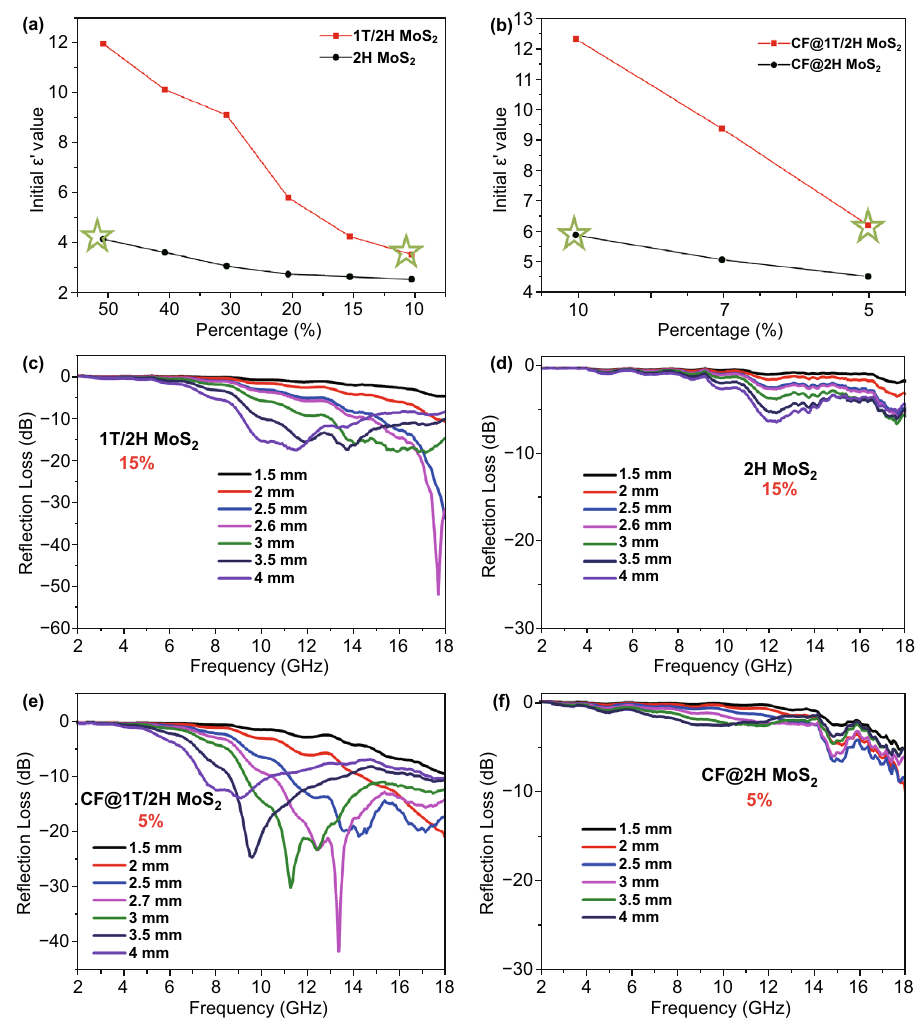
Fig. 5 a , b Matrix loading percentage–initial ε ′ of 1T/2H MoS 2 and 2H MoS 2 , CF@1T/2H MoS 2 and CF@2H MoS 2 . c , d Calculated reflection loss of 1T/2H MoS 2 and 2H MoS 2 with the matrix loading of 15wt%. e , f CF@1T/2H MoS 2 and CF@2H MoS 2 with the matrix loading of